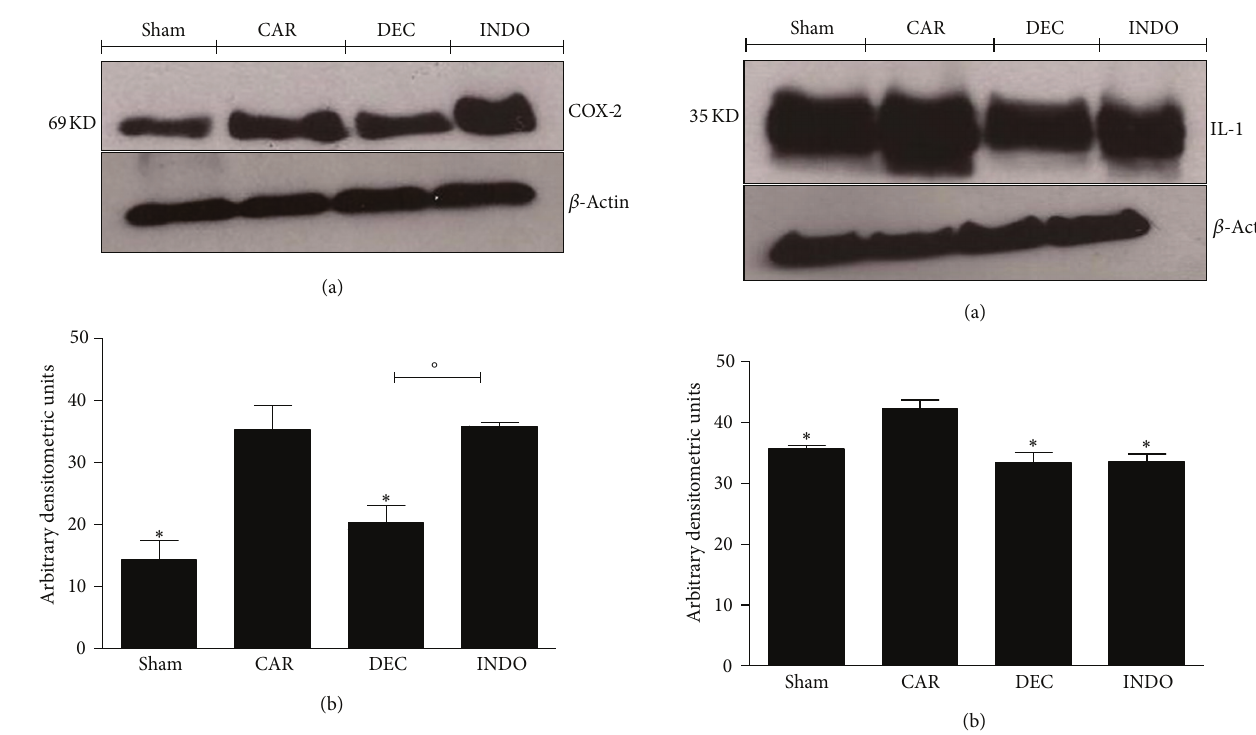
Figure 11: Effects of DEC on carrageenan-induced IL-1 𝛽 expression in the lung. Basal expression of IL-1 𝛽 was detected in lung samples obtained from the sham group, whereas levels of IL-1 𝛽 were significantly increased in the lung tissue from animals 4 hours after injection of carrageenan. Treatment with DEC and INDO reduced the expression of IL-1 𝛽 in comparison to the CAR group. (a) Representative blot of lysates obtained from pool 4 animals per group; (b) data expressed as mean ± S.E.M. of 3 replications for each group; ∗ 𝑃 < 0.05 versus